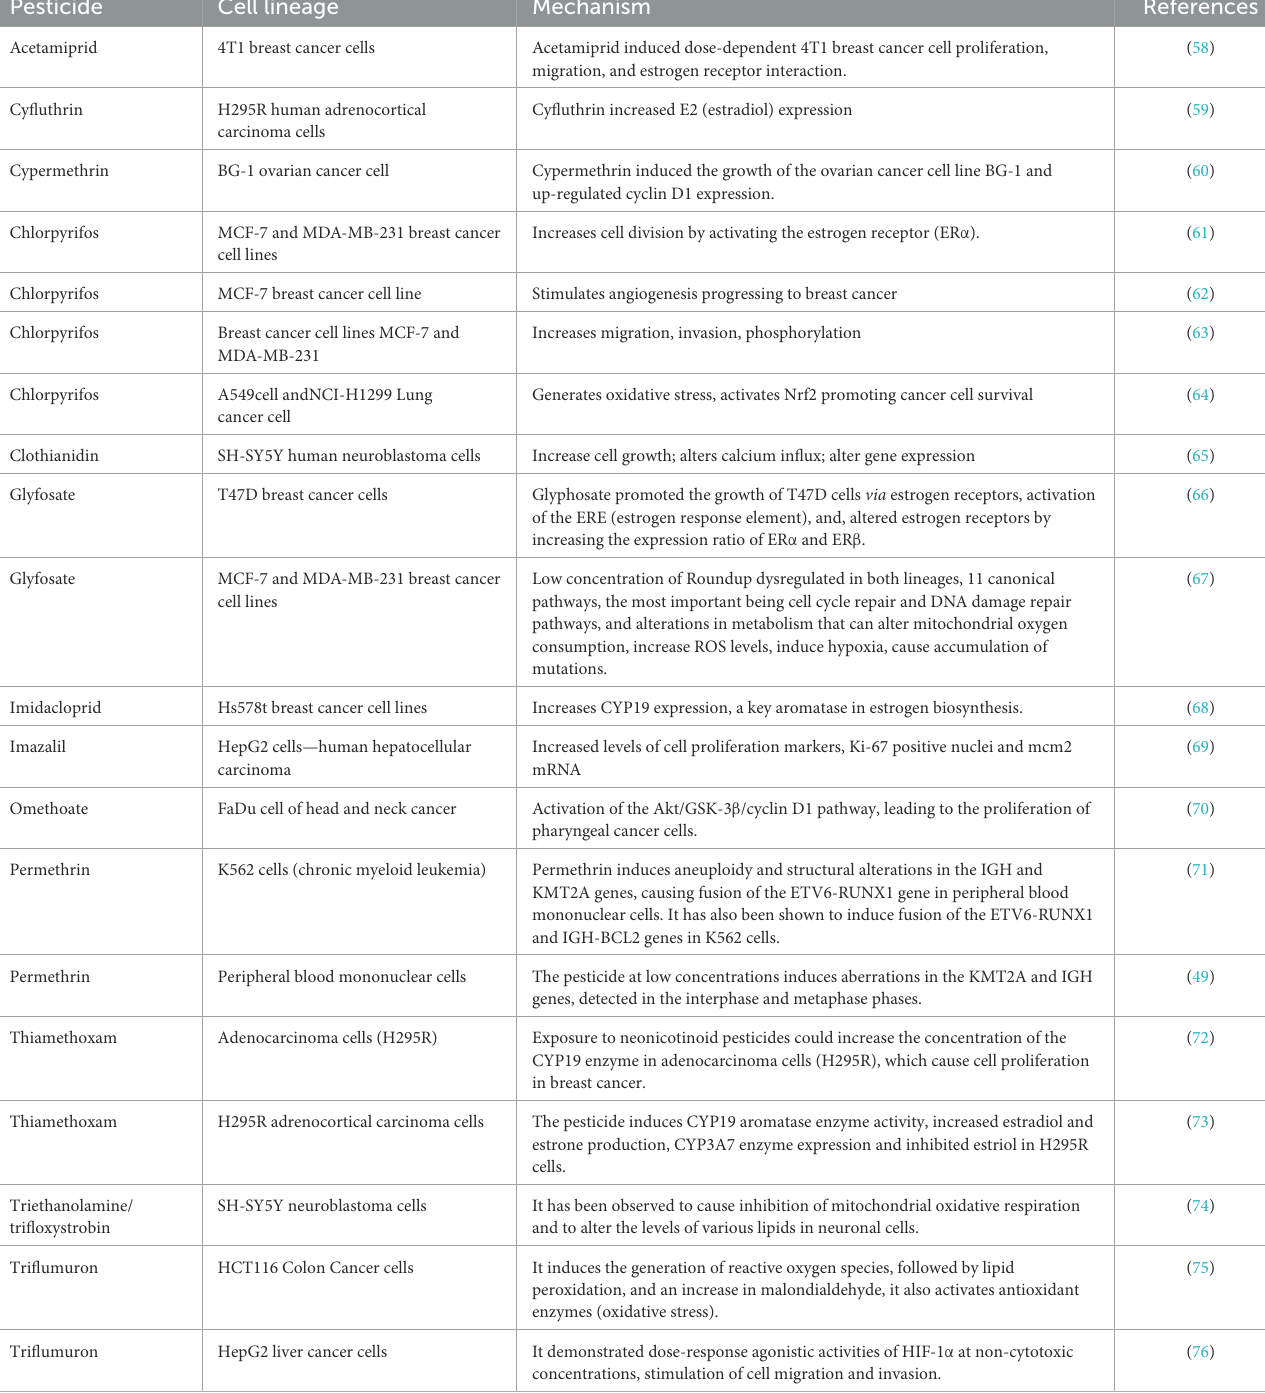
TABLE 5 Mechanisms associated with in vitro carcinogenesis following exposure to pesticides. Pesticide Cell